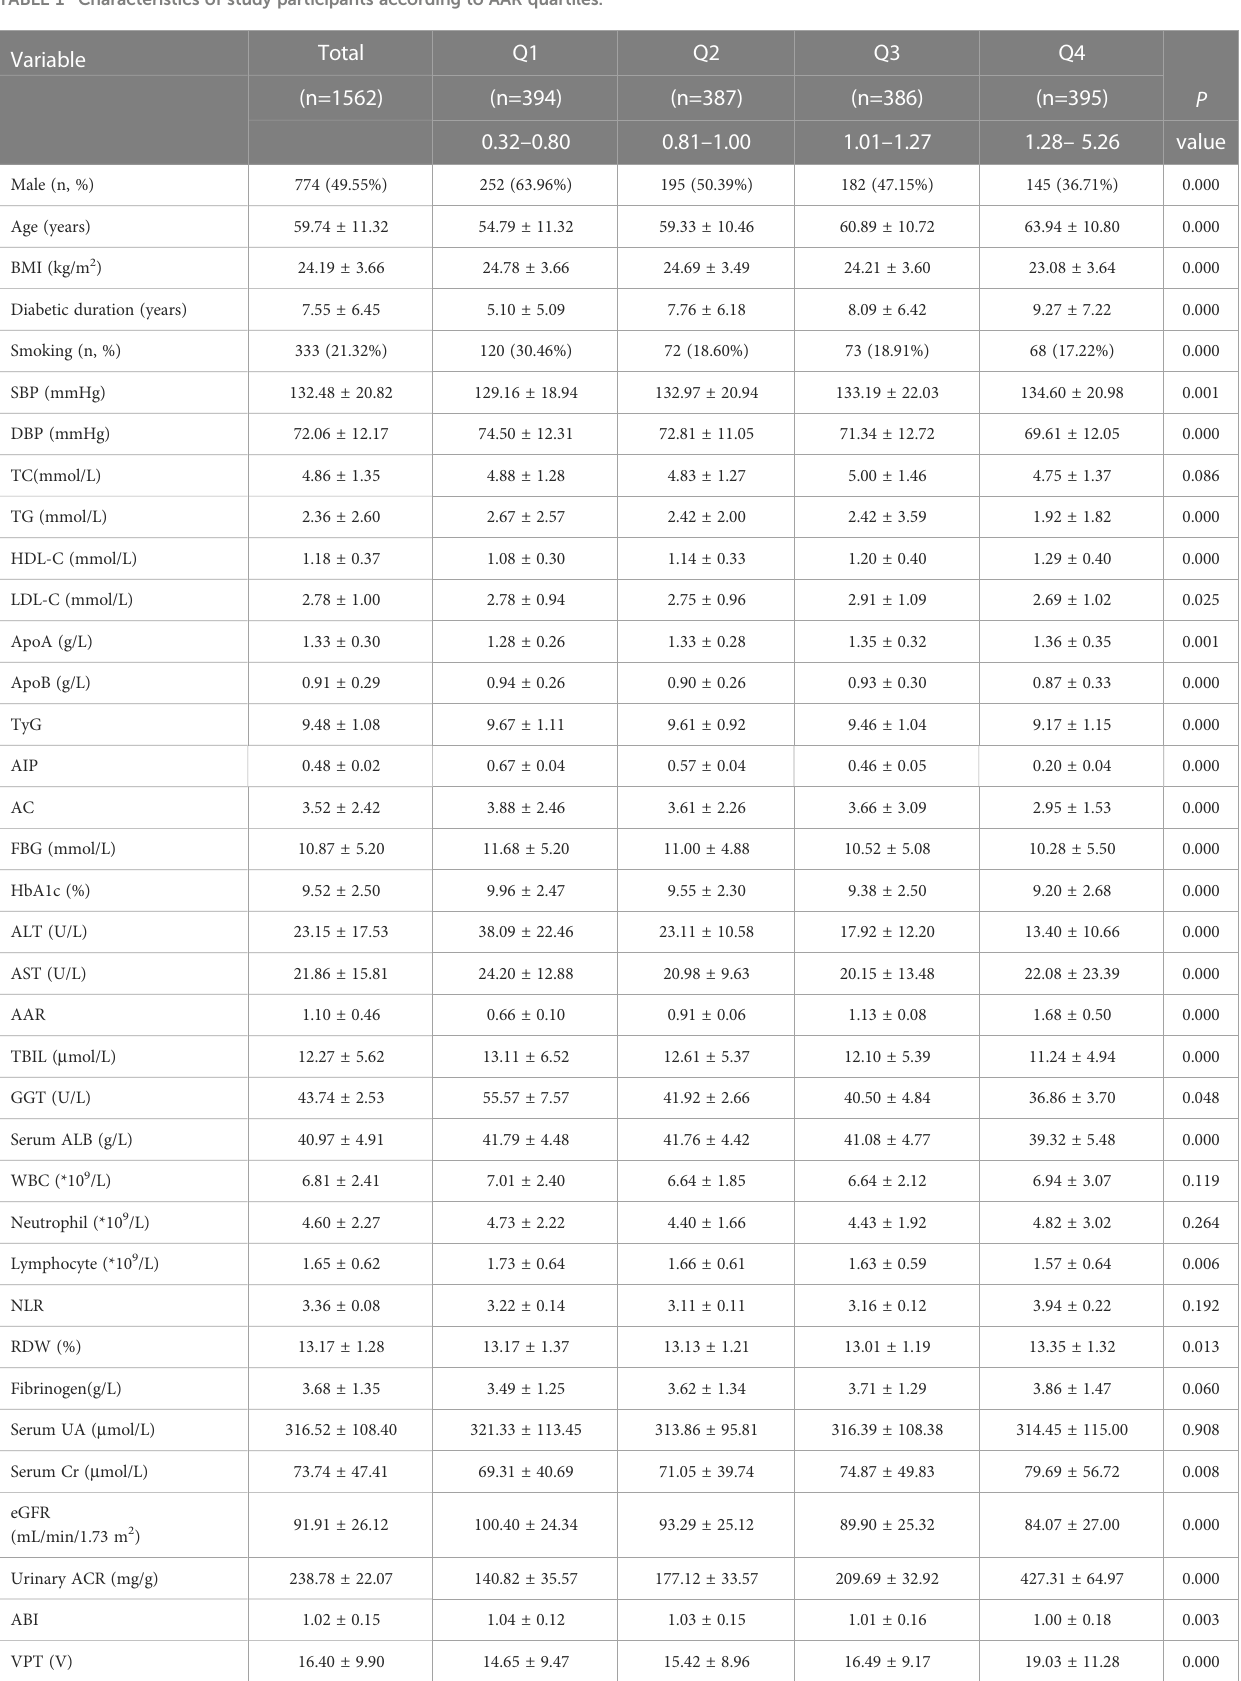
TABLE 1 Characteristics of study participants according to AAR quartiles.